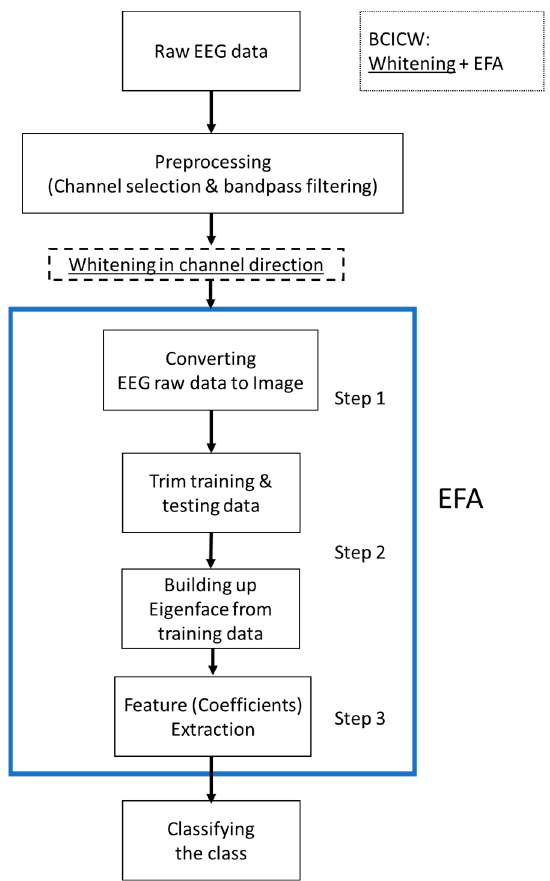
Figure 2. EFA algorithm procedure related to BCICW.